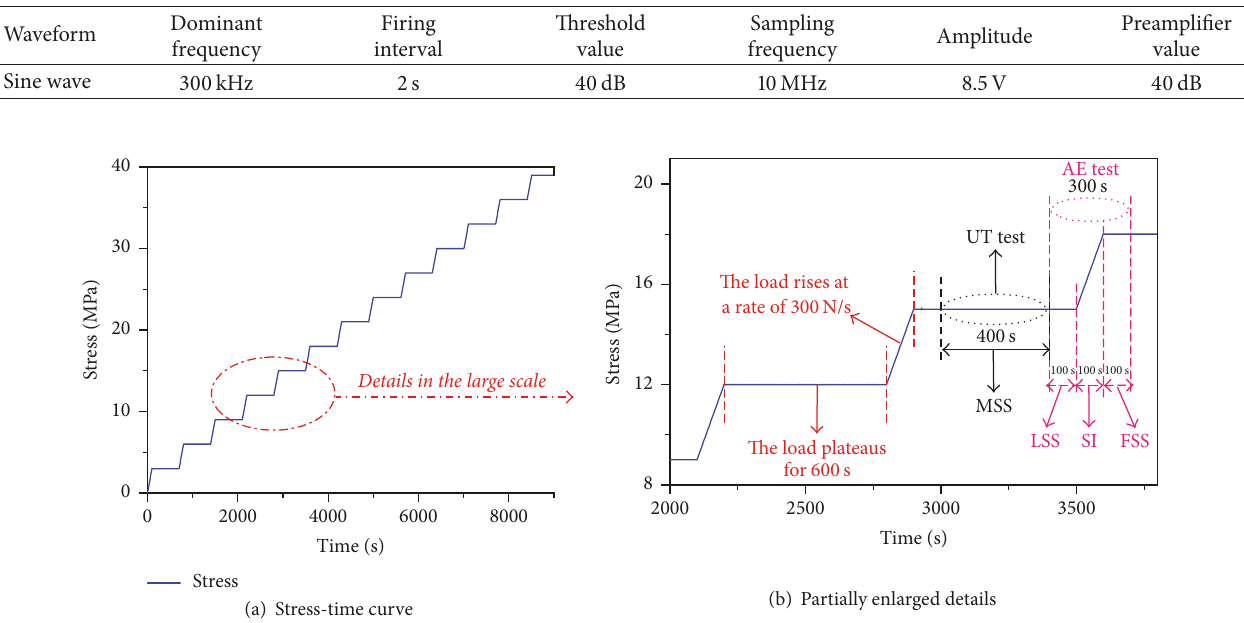
Table 2: The detailed information of the generated UT signals.